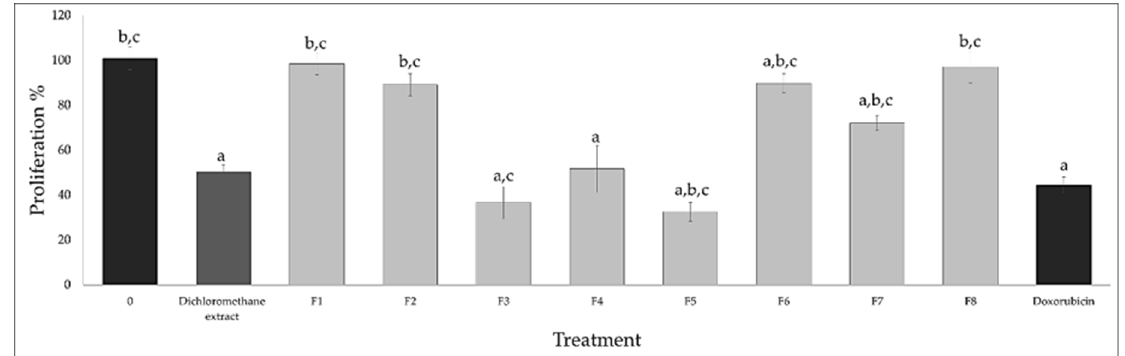
Figure 4. Antiproliferative activity of the IC 50 of extracts S. edule cv. Madre Negra of the complete extract in dichloromethane and the fractions F1-F8. The letters mean: “a”: significant difference versus control (0) ( p < 0.05), ”b”: significant difference versus positive control for the inhibition of proliferation (5 ng/mL of doxorubicin) ( p < 0.05), “c”: significant difference versus the complete dichloromethane extract, (0.58 µ g/mL) ( p < 0.05) (ANOVA with a Tukey test). The bars indicate ± standard